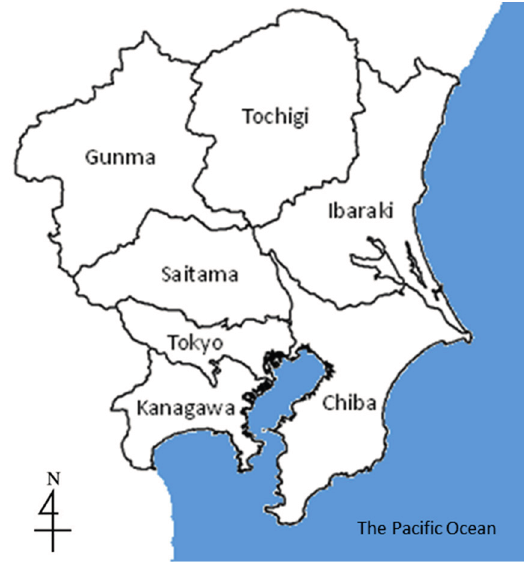
Figure 1. Map of seven prefectures of Kanto region in